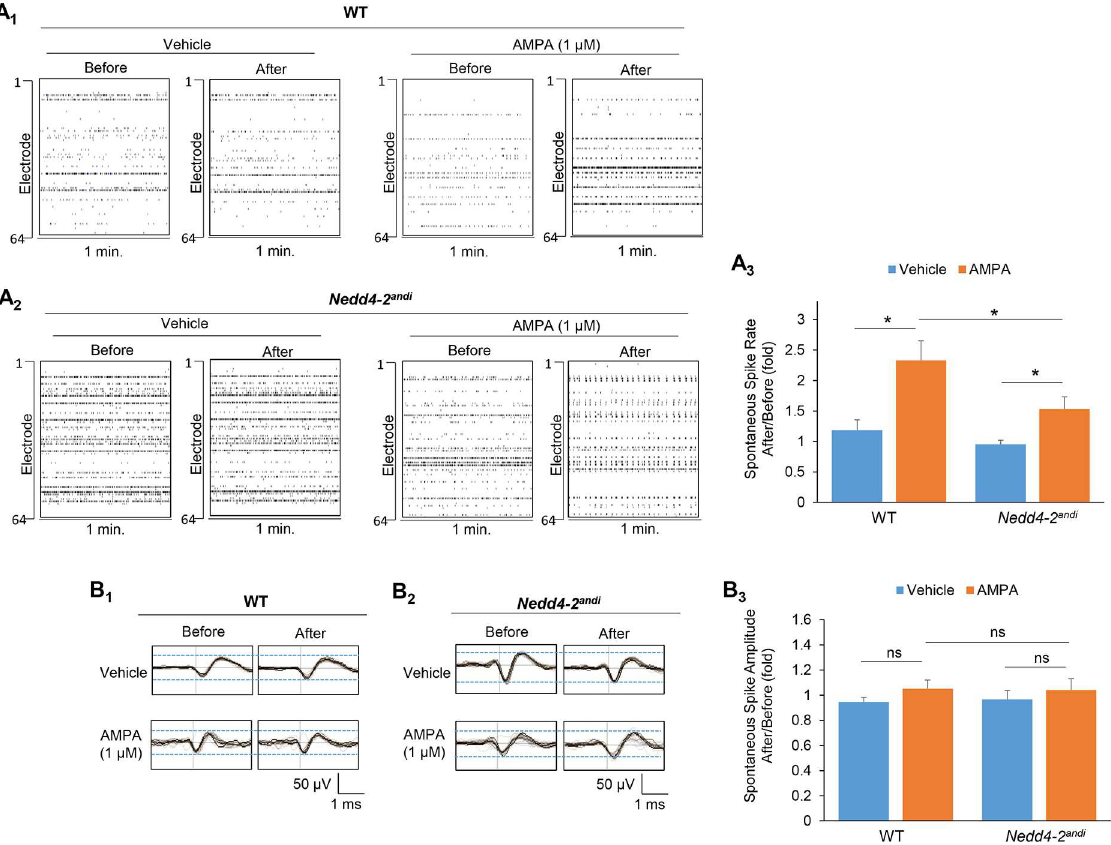
Fig 2. Acute AMPAR activation triggers stronger elevation of spontaneous neuronal activity in WT than Nedd4-2 andi cortical neuron cultures. ( A ) Representative raster plots and quantificationof spontaneousspikes from 1-min recording(right) of ( A 1 ) WT or ( A 2 ) Nedd4-2 andi cortical neuroncultures before and after vehicle (ddH 2 O) or AMPA (1 μ M) treatment for 15 min. (Vehicle: n = 6 and 9 for WT and Nedd4-2 andi ; AMPA: n = 7 and 11 for WT and Nedd4-2 andi ) ( B ) Representative averagetraces of 1-min recordingand quantification of averagespontaneous spike amplitudeof ( B 1 ) WT or ( B 2 ) Nedd4-2 andi cortical neuroncultures before and after vehicle (ddH 2 O) or AMPA (1 μ M) treatment for 15 min (Vehicle: n = 6 and 9 for WT and Nedd4-2 andi ; AMPA: n = 7 and 11 for WT and Nedd4-2 andi ). The black lines represent the averageof all the spikes within representative 1-min recordings. Data are analyzedby a 2-way ANOVA with post-hoc Tukey test and represented as mean ± SEM. The comparisonbetween treatments or genotypes is describedwith * p < 0.05,ns: non-significant. Significantinteraction betweentreatment and genotype was detected in spontaneous spike rate (A 3 ; p < 0.05)but not amplitude(B 3 ; p >